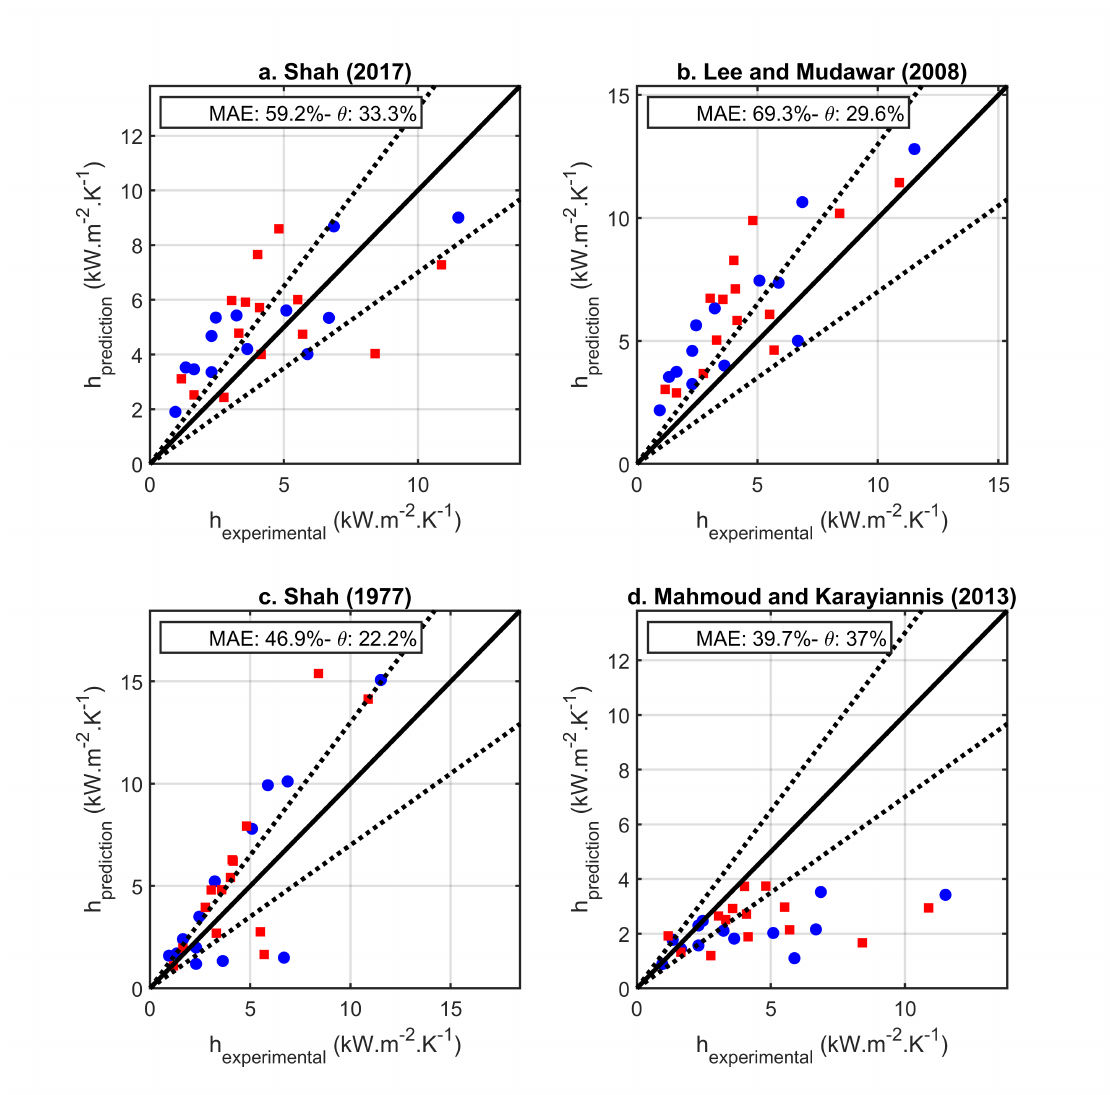
Figure 12. Comparison of experimental results with existing heat transfer correlations. Red squares are acquired results from channel 1.5 mm ˆ 0.5 mm and blue circles are acquired results from channel 1.05 mm ˆ 0.5 mm. Dashed lines are depicting ˘ 30% error band. ( a ) [46] ( b ) [47] ( c ) [45] ( d )